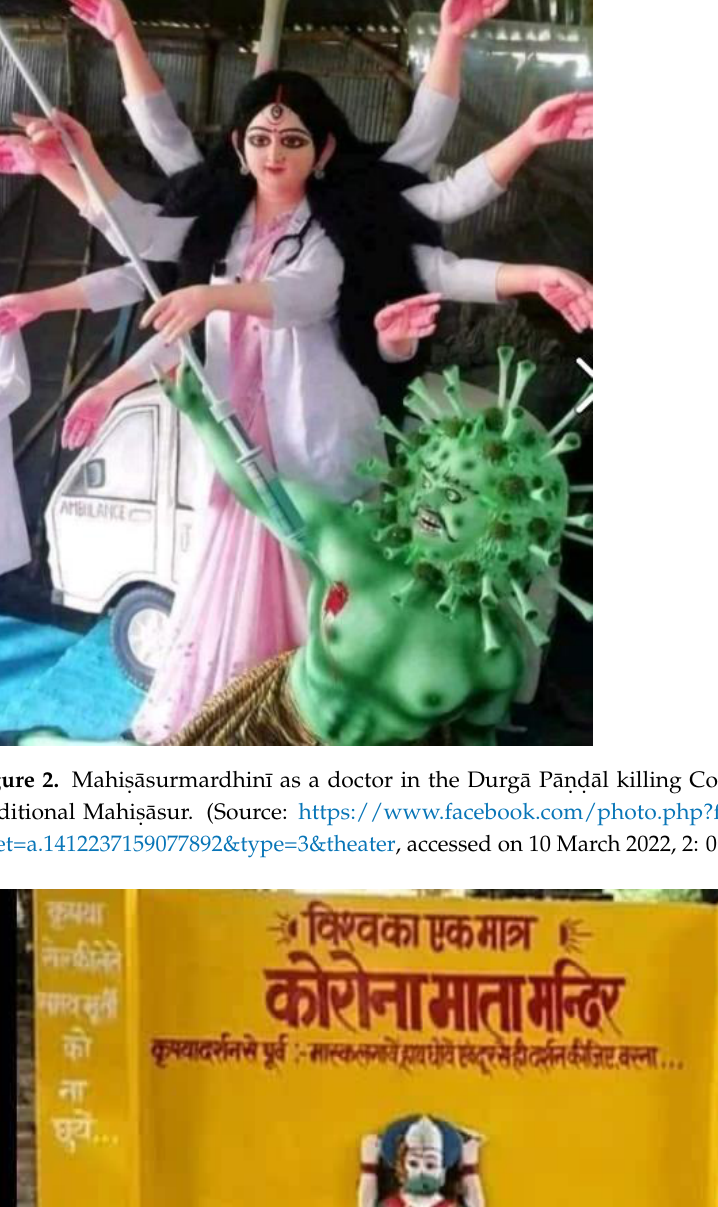
Figure 4. Corona Mātā shrine with Mu ṇḍ amālā and triśūl, Coimbatore, Tamil Nadu. Used with th e photographer’s permission.